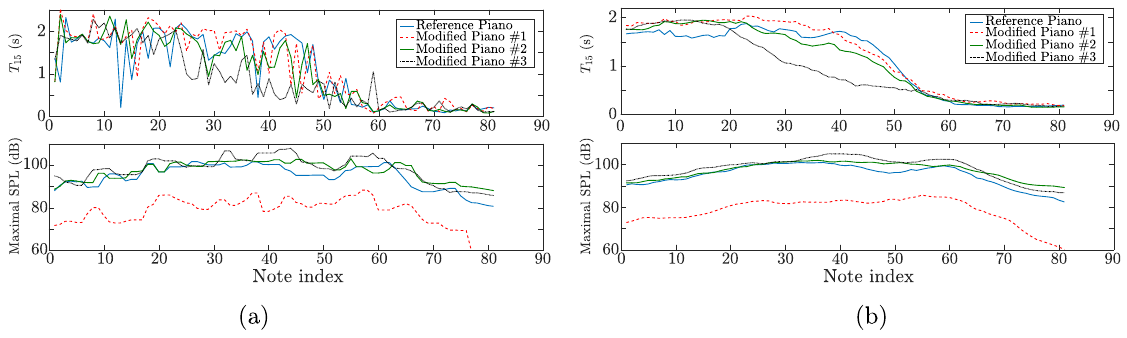
Figure 8. Energy decay time T 15 (top) and maximal sound pressure level (bottom) computed from the simulated piano tones over the tessitura. Left (a) are the non-averaged features, and right (b) are the locally averaged features over an